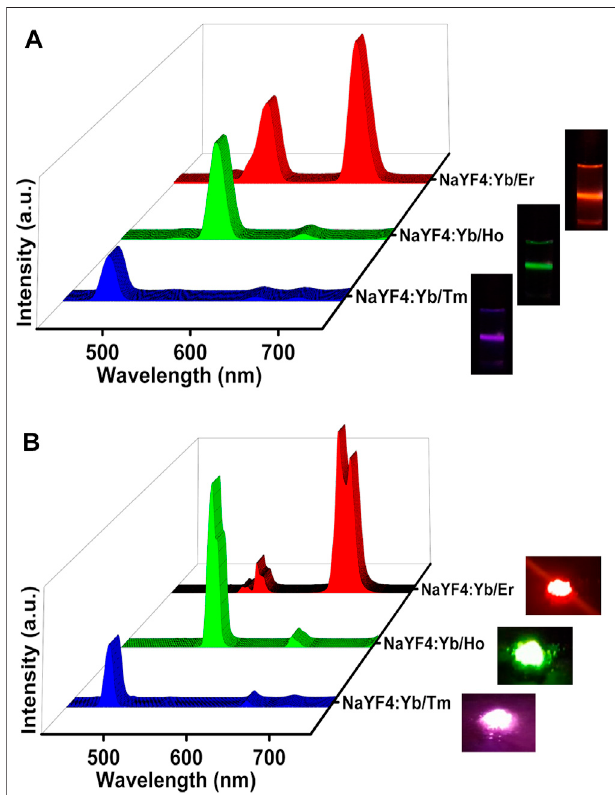
FIGURE 3 | UCL spectra of NaYF 4 :Yb/Tm (blue emitting), NaYF 4 :Yb/Ho UCNPs (green emitting) and NaYF 4 :Yb/Er (red emitting) nanophosphors (A) in the solution state and (B) in the solid state. The corresponding photographic images of the solution and powder samples upon illumination using a 980 nm torch laser are shown on the right.